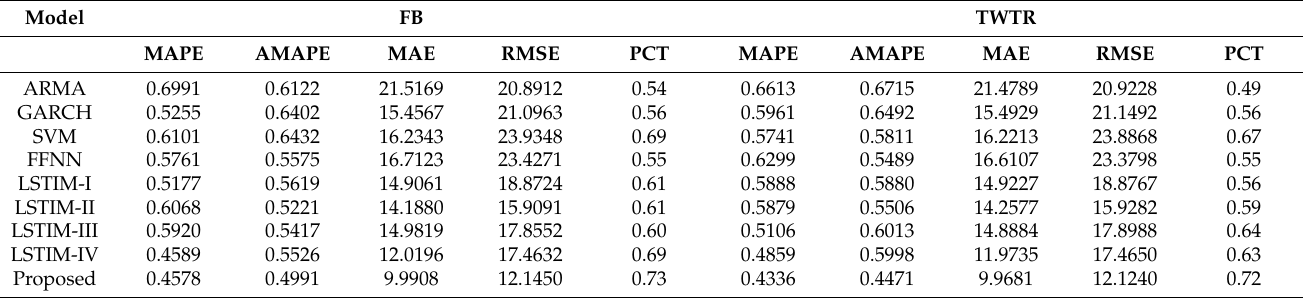
Table 14. Prediction performance for 300 days: FB and TWTR.